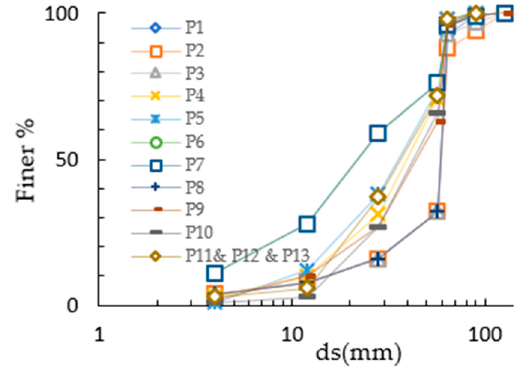
Figure 3. Grain size distribution of bed material around vegetation patches.